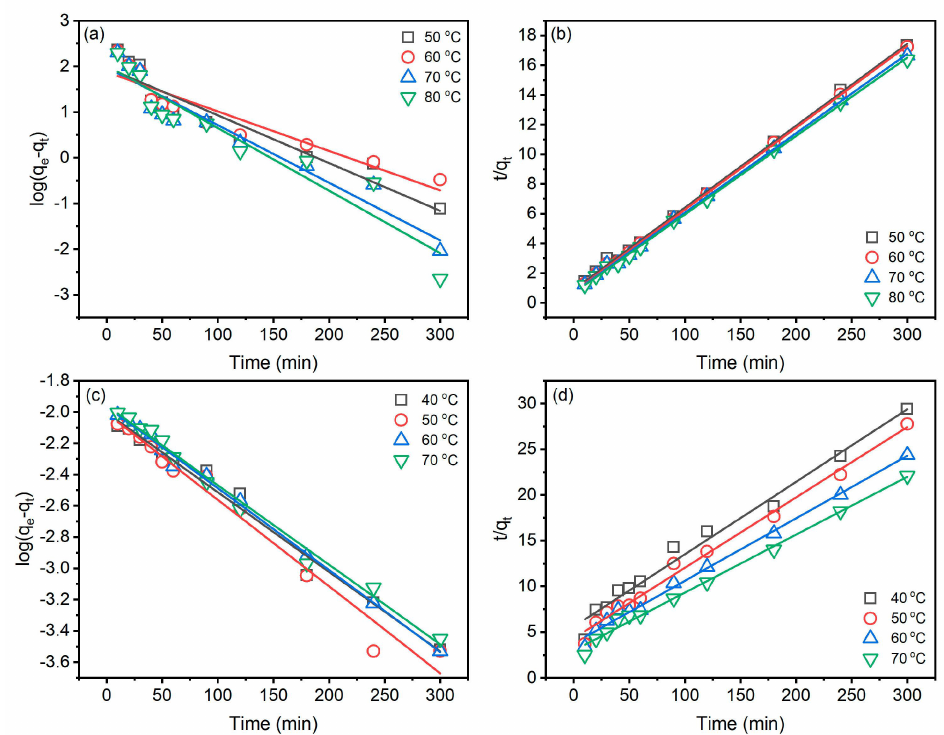
Figure 5. Kinetic characteristics of Reactive Blue 194 dye adsorption in the dyeing of raw ramie yarn in palm oil medium: ( a ) pseudo-first-order and ( b ) pseudo-second-order and in water medium: ( c ) pseudo-first-order and ( d )